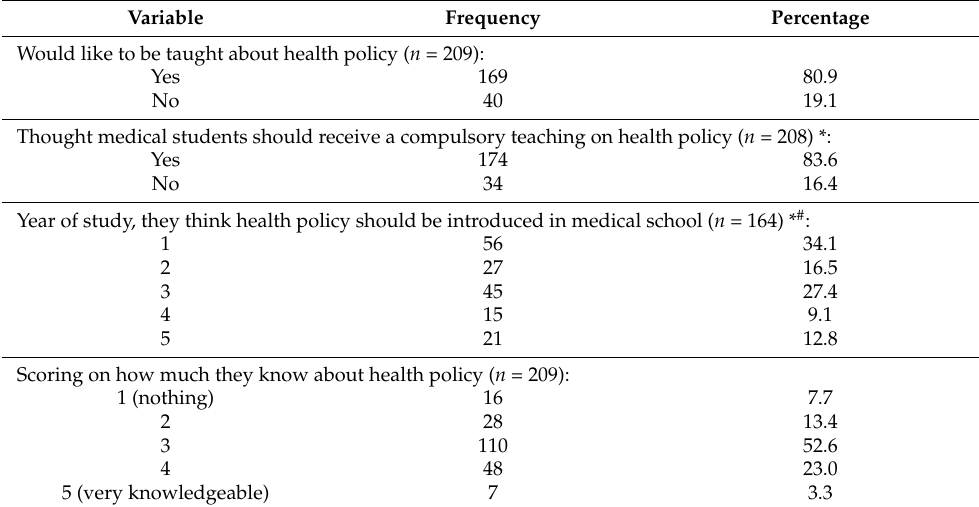
Table 2. Responses to health policy teaching and knowledge ( n =